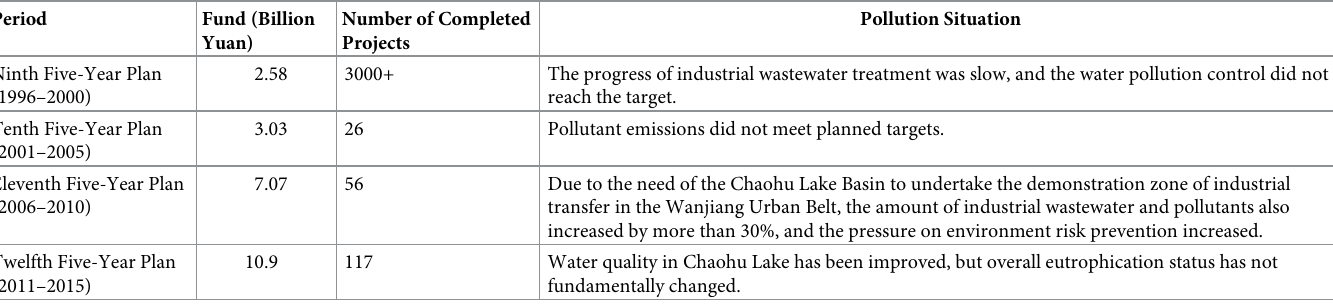
Table 1. Number of governance funds and projects invested in Chaohu Lake,